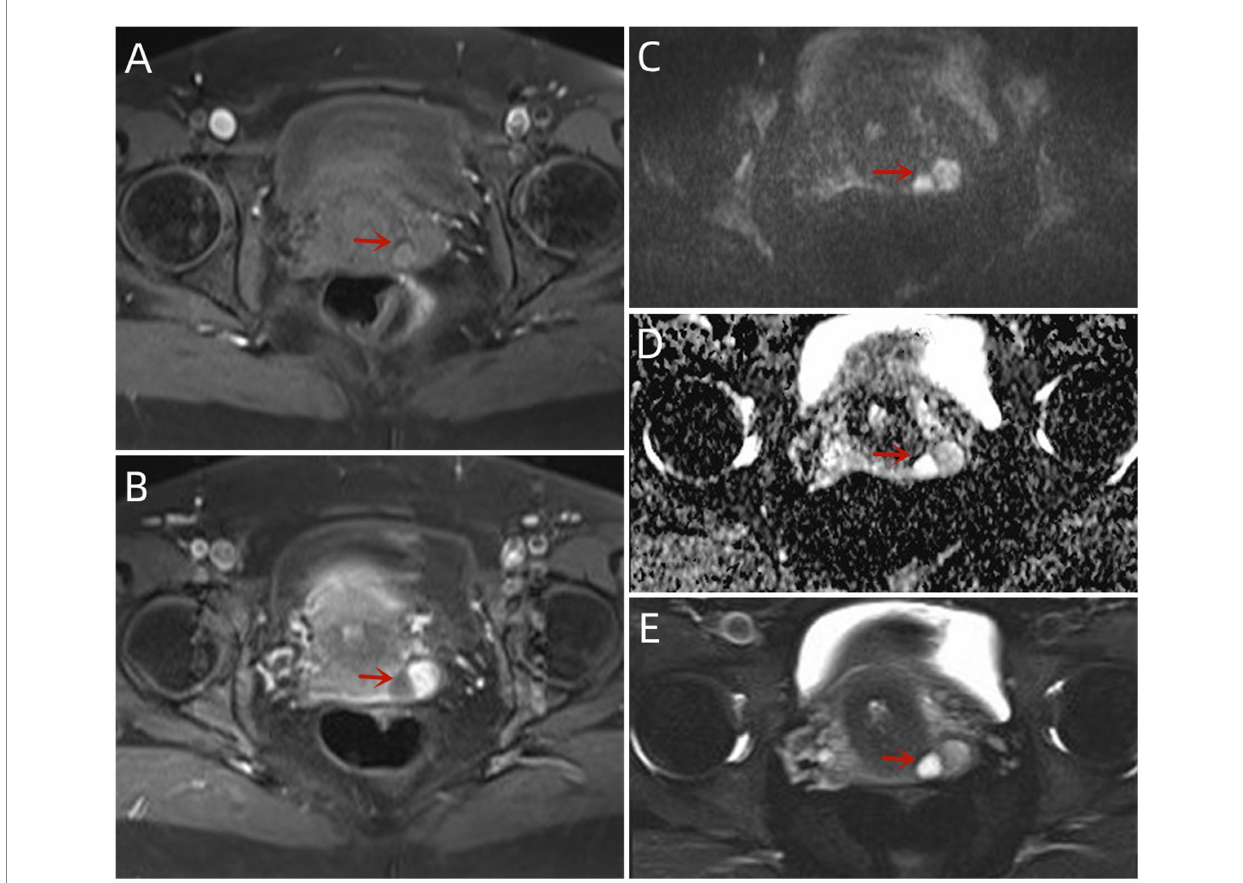
FIGURE 1 MRI findings of this case: (A) The lesions with the T2-FS sequence exhibited an uneven hypersignal. The right side exhibited a T2 hypersignal, similar to fluid. Magnetic resonance imaging findings of this case: (B,C) Both diffusion-weighted imaging (B800) and apparent diffusion coefficient lesions exhibited high signals with an unrestricted diffusion. (D) The T1-FS lesions had uneven and slightly hyperactive signals. (E) Enhancement of the left side of the lesion was observed after intravenous injection of contrast